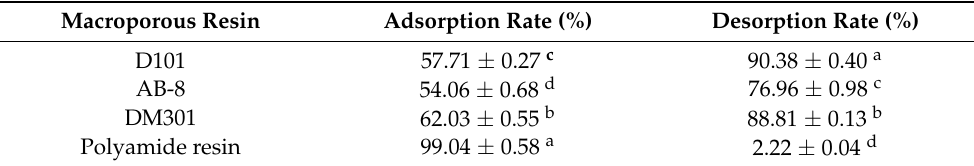
Figure 2. Mycelial growth and SHF production under SSF: ( a ) mycelial yield under SSF; ( b ) SHF content per g of mycelia under SSF; ( c ) total SHF content under SSF; and ( d ) the maximum of total SHF content accumulation in nine strains. Differing letters above bars indicate significant ( p < 0.05) differences according to Tukey’s multiple comparisons test. Table 4. Adsorption rates and desorption rates of SHFs in various macroporous